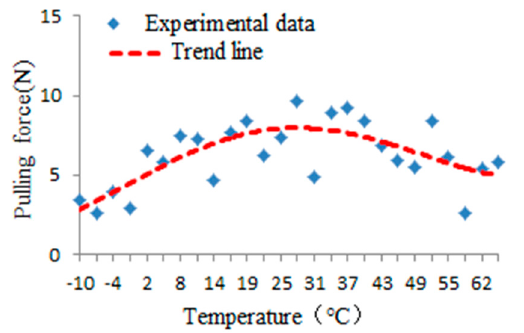
Figure 14. Three-point tensile ultimate force temperature curve. Table 9. Three-point tensile test blades tensile limit at each temperature. Temperature / ◦